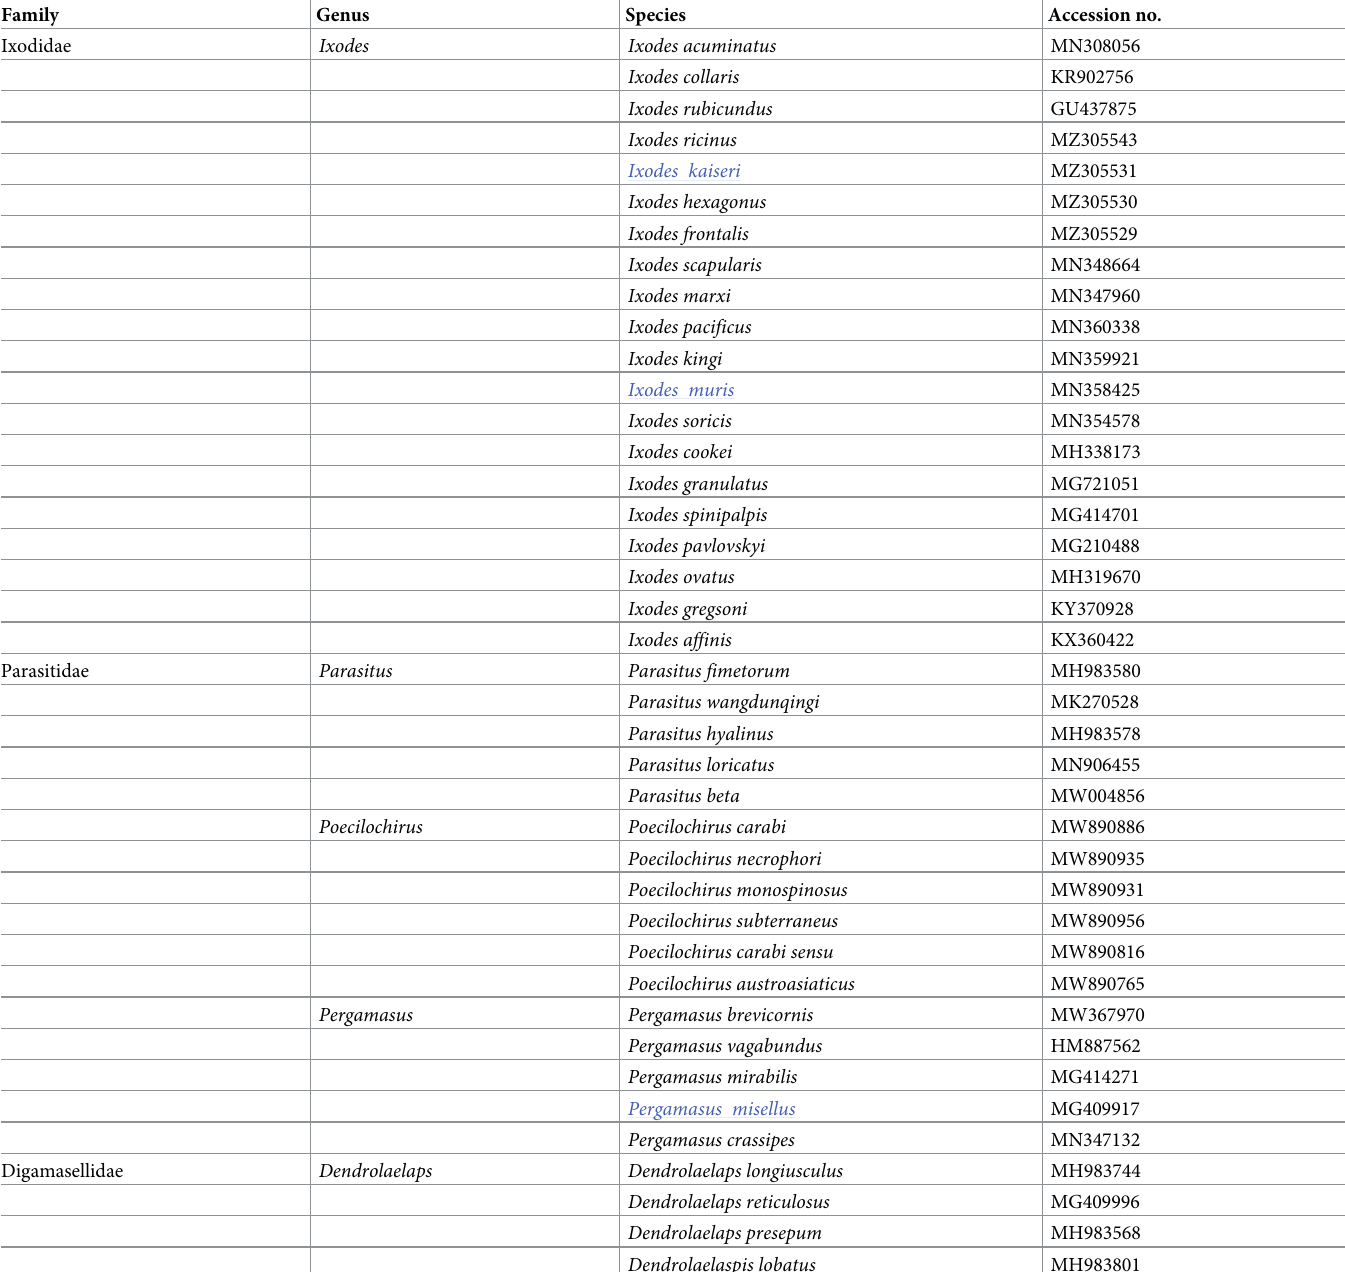
Table 2. Sequence information of species in the families Ixodidae, Parasitidae and Digamasellidae in this study.